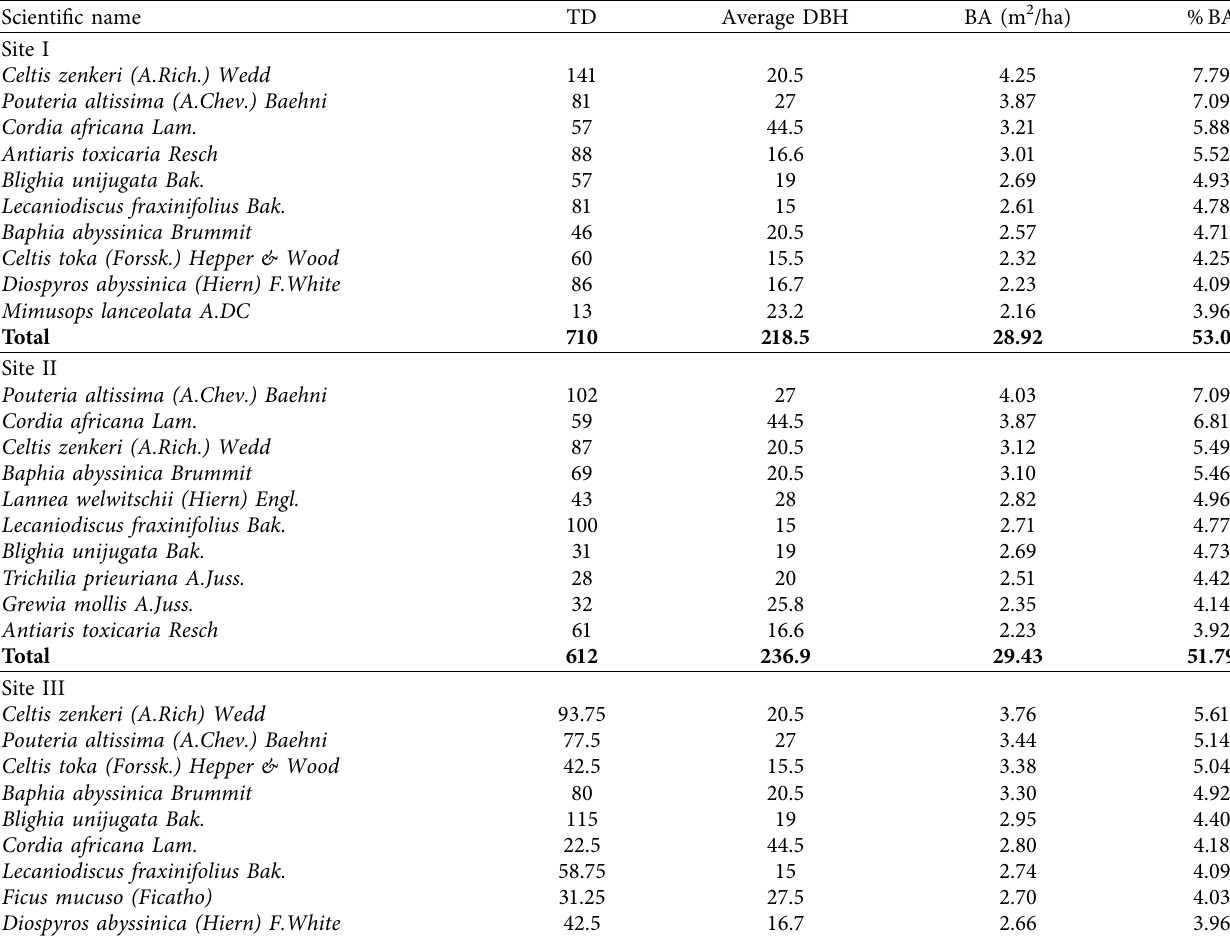
Figure 6: Frequency class distribution of woody species. Table 9: Dominant trees with their BA and percentage in all the sites of